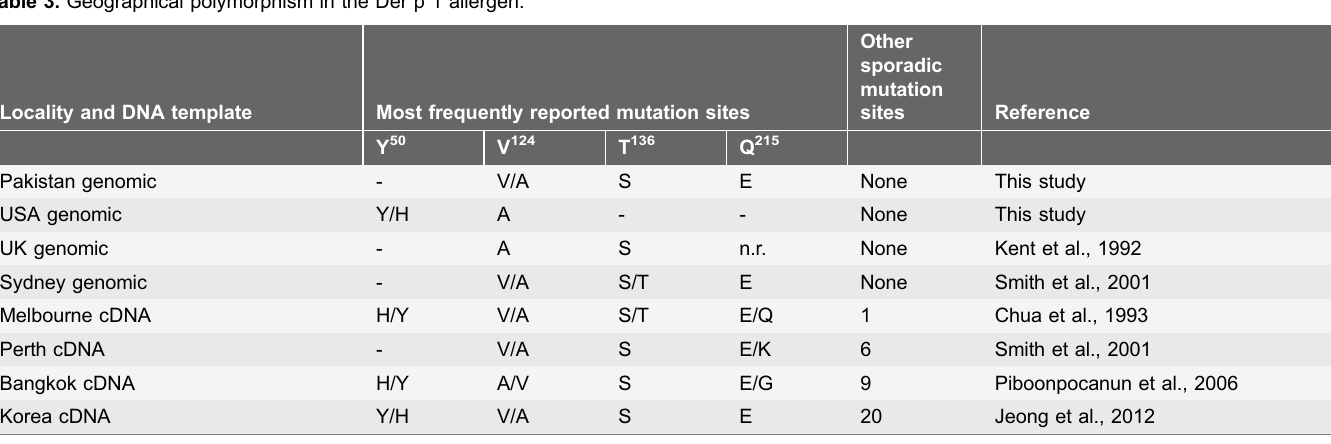
Table 3. Geographical polymorphism in the Der p 1 allergen.